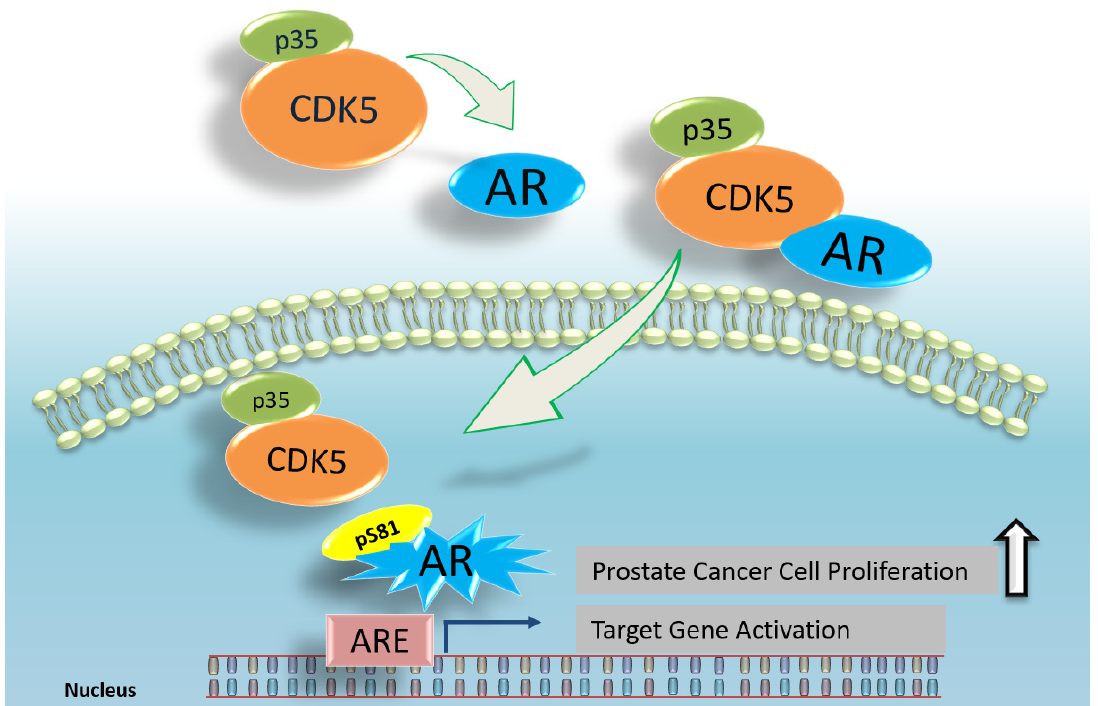
Figure 2. A schematic representation of the regulation of androgen receptor (AR) protein by the interaction of CDK5 and p35. CDK5 and p35 regulate AR by direct biochemical interaction. CDK5 increases the stabilization and transcriptional activation of the AR protein. The consequence of this regulation is the promotion of prostate cancer cell growth.